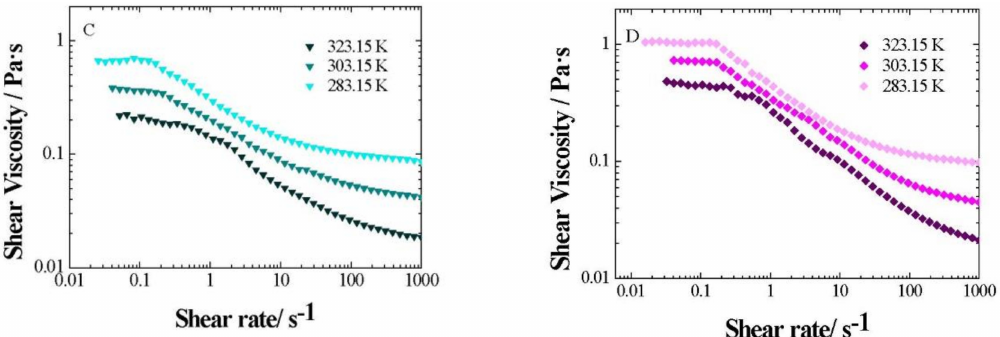
Figure 9. Shear viscosity change with shear rate ( γ ) for xGnP/PG nanofluids at different weight fractions: ( A ) 0.5 wt%, ( B ) 1 wt %, ( C ) 2 wt % and ( D ) 3 wt %, between 283.15 and 323.15